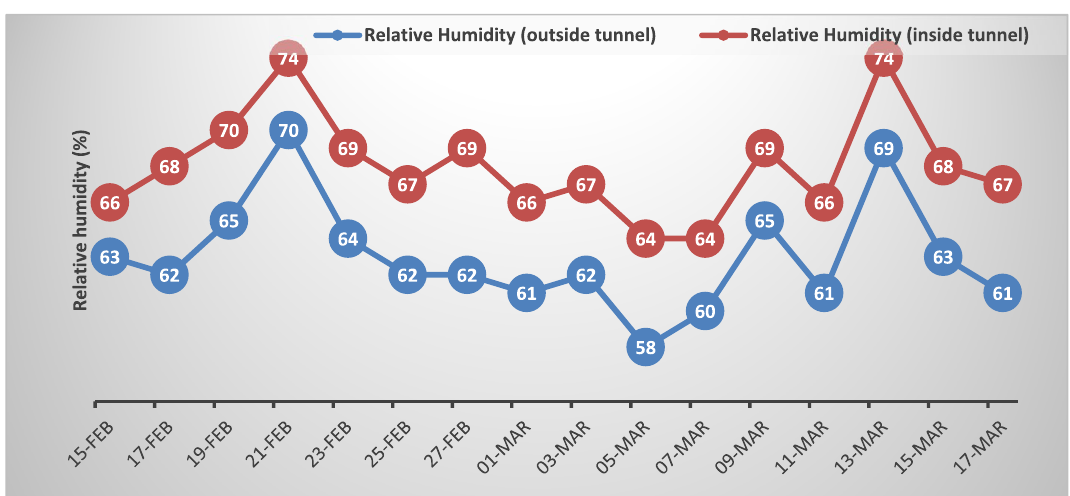
Figure 2. Relative humidity recorded outside and inside the plastic tunnel when the wheat plants reached to heading stage (75 days after sowing) for 30